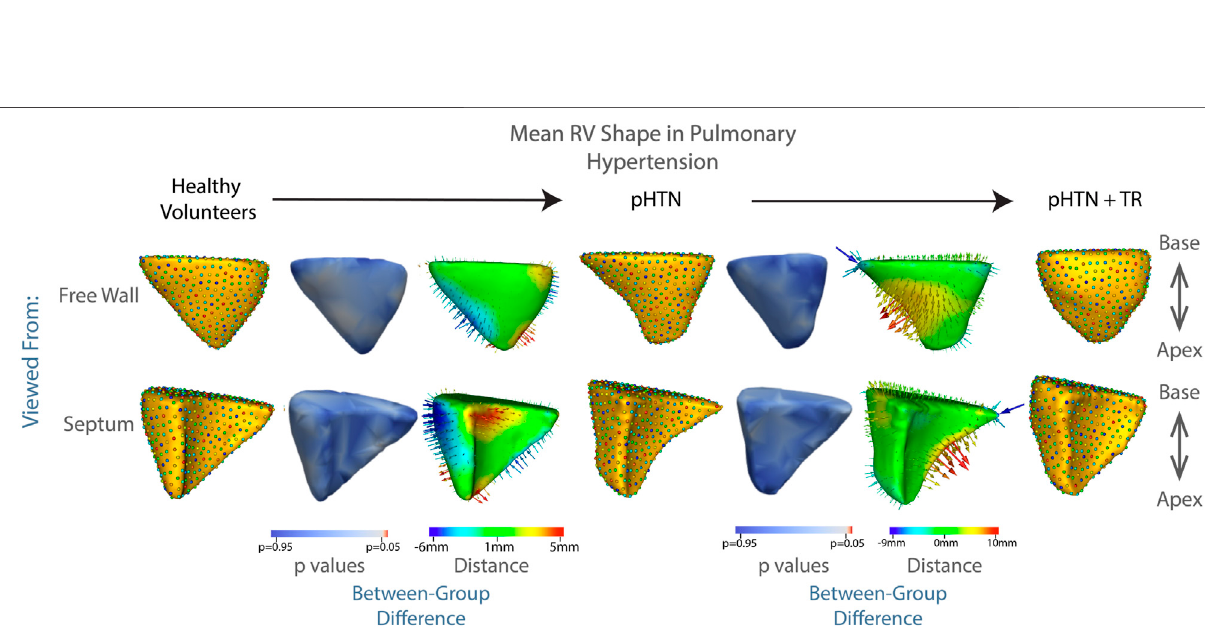
Frontiers in Physiology |